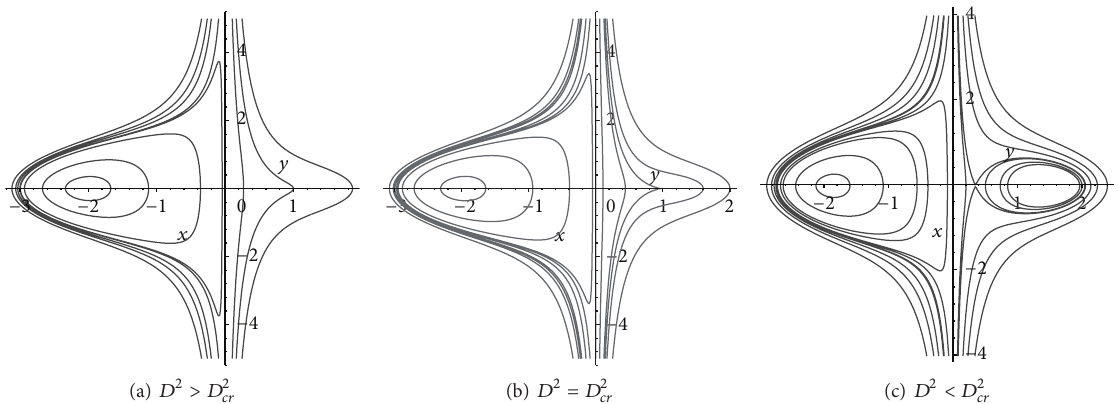
Figure 1: The phase portraits of system (6) for 𝑛 = 2𝑚 , 𝛽 > 0 , 𝐺 1 > 0 , and 𝜎 > 0 .